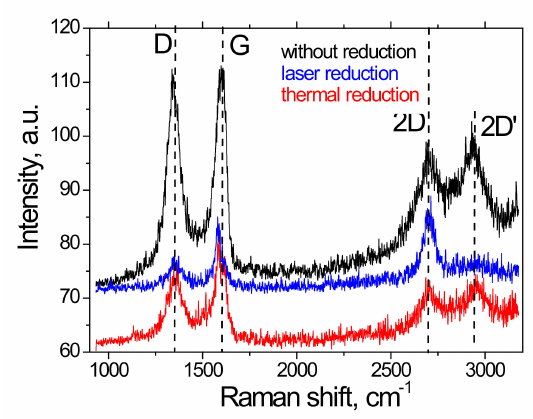
Figure 6. Raman spectra for the original MOG film and films reduction with a laser and thermal